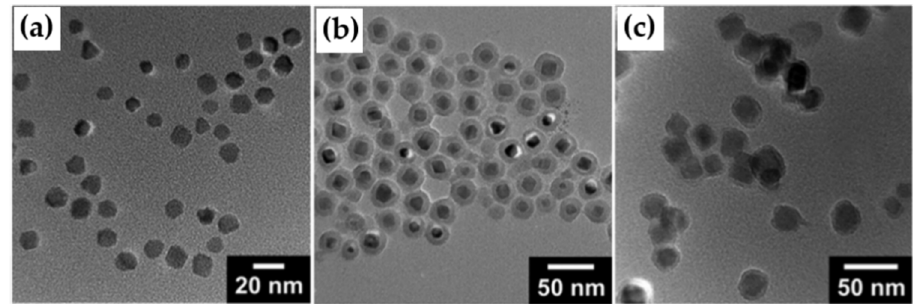
Figure 5. TEM images ( a ) Fe 3 O 4, ( b ) Fe 3 O 4 / SiO 2, and ( c ) Fe 3 O 4 / SiO 2 / GO [65].